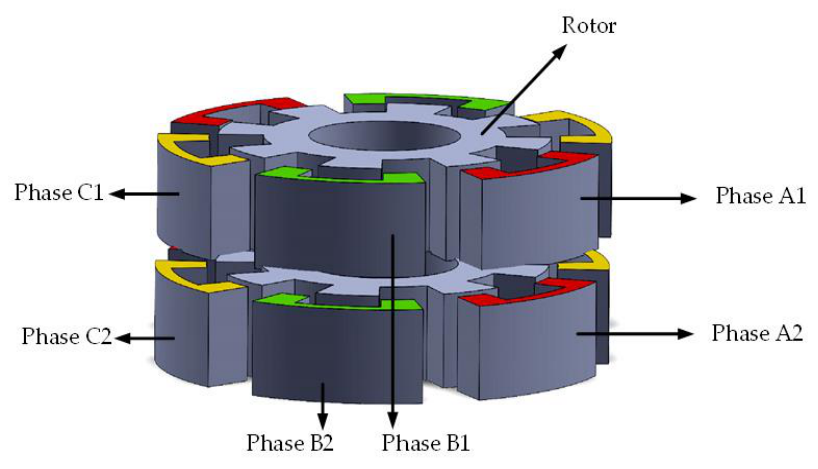
Figure 8. Output torque of three groups of machines under different excitation currents [31]. and durability, but its vibration caused by the torque ripple has been criticized. As shown in Figure 9, a double-layer SRM is proposed in [34] to reduce the torque ripple and realize smooth operation of the machine by optimizing the topology of SRM. Not limited to the double-layer structure, a higher-level SRM machine topology is proposed in [35,36]. By adopting an optimized multi-level structure, the torque ripple, vibration, and noise of the SRM are effectively reduced.